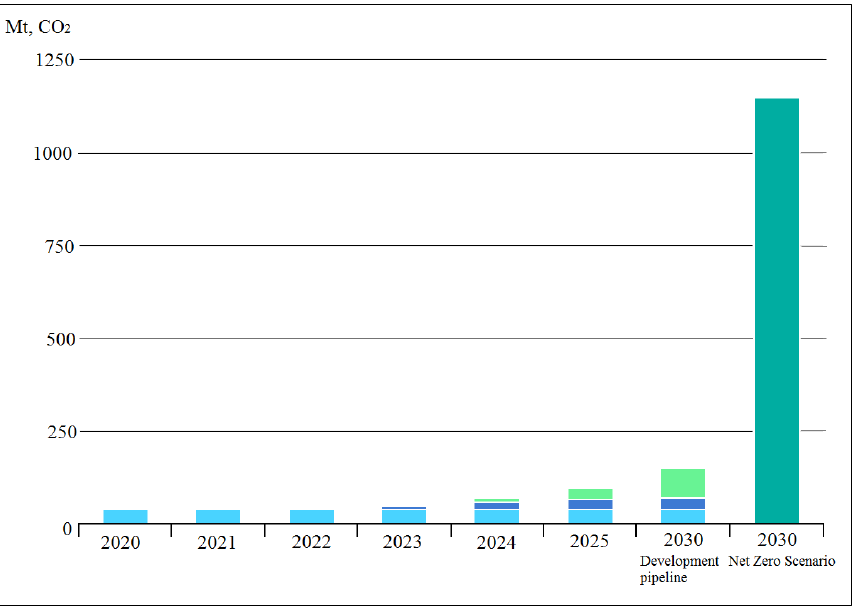
Figure 3. Comparison of the Net Zero Scenario 2020 – 2030 with actual industrial CO 2 capture pro- jects.